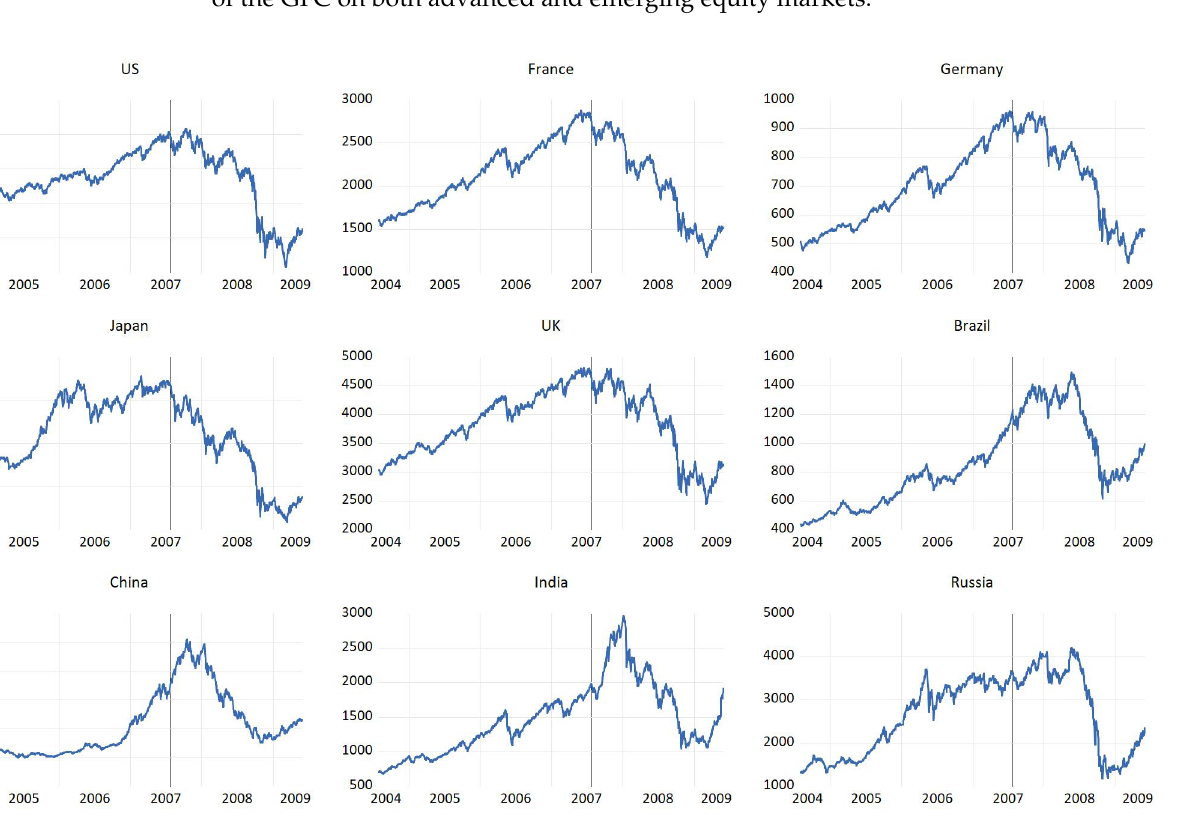
Figure 1. Aggregate equity market